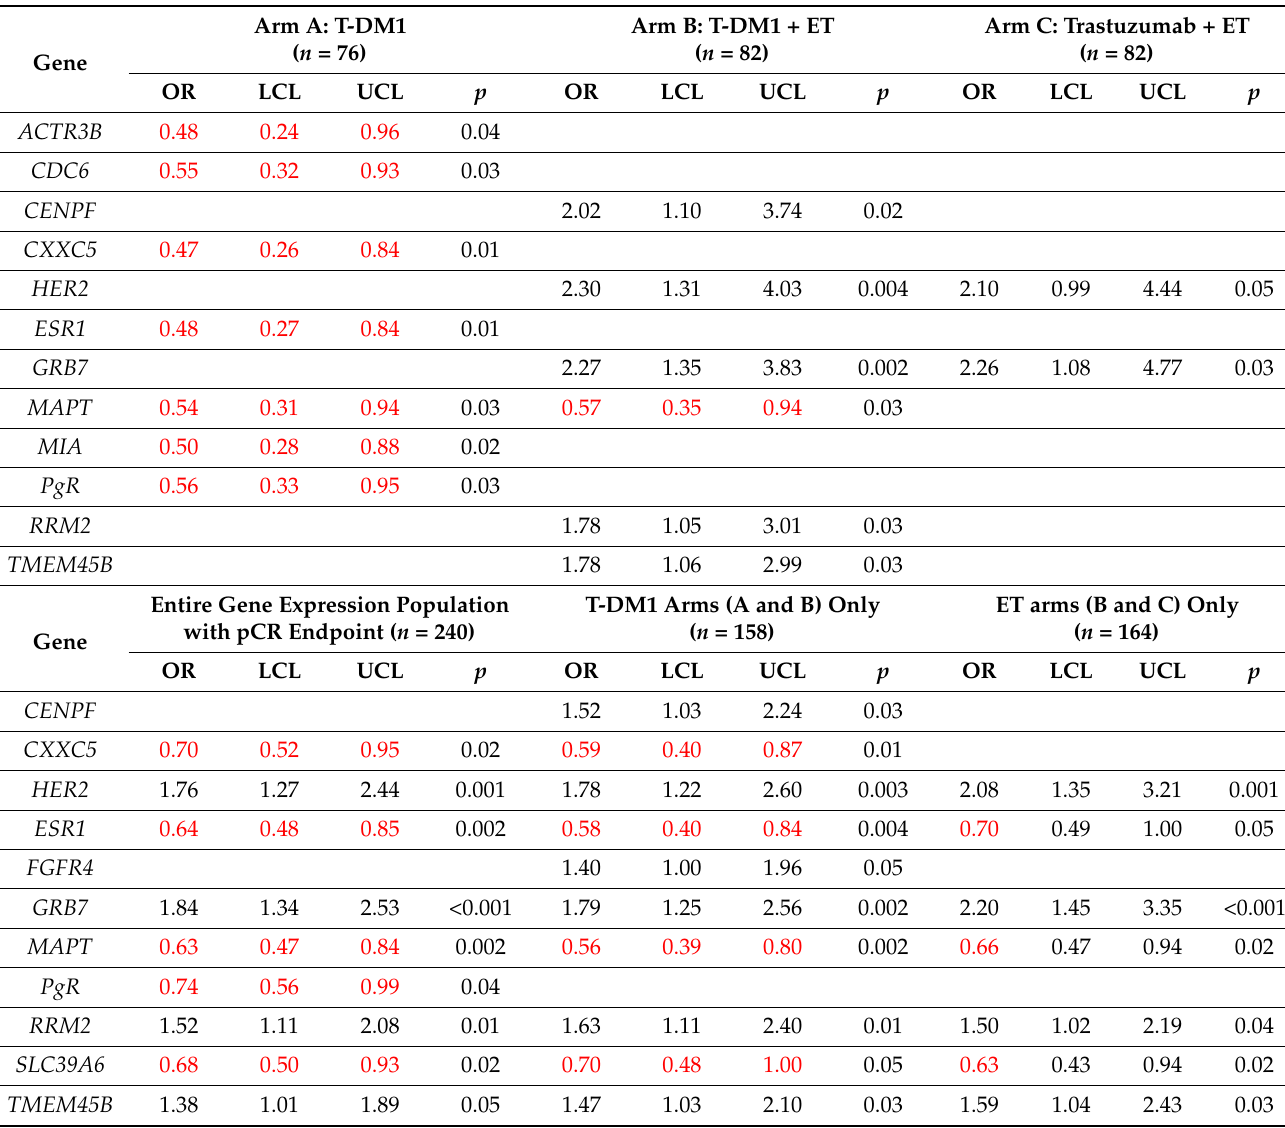
Spearman correlations of CD8/CNT change existed for CD8 and PD-L1 gene expression (in the positive sense), and for ACTR3B , ESR1 , MLPH , BCL2 , CXXC5 , SLC39A6 , and FOXA1 (in the negative sense). However, none of these correlations exceeded 0.35 in magnitude. Stepwise multiple regression analysis of CD8/CNT change on gene expression suggested that CD8 (gene) and KNTC2 were independent positive and that CDH3 and ESR1 were independent negative predictors of immune response. Table 2. Unadjusted ORs of (standardized) gene expression measurements for pCR (with 95% confidence intervals) by univariable logistic regression (genes with significant impact). ORs ≤ 1 are shown in red; ORs > 1 are shown in black.